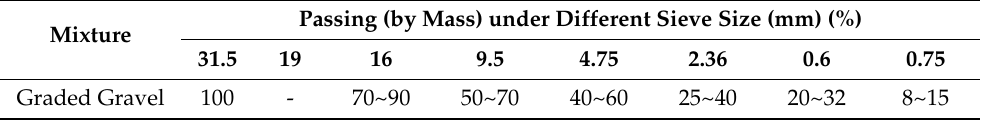
Table 1. The gradation of the graded